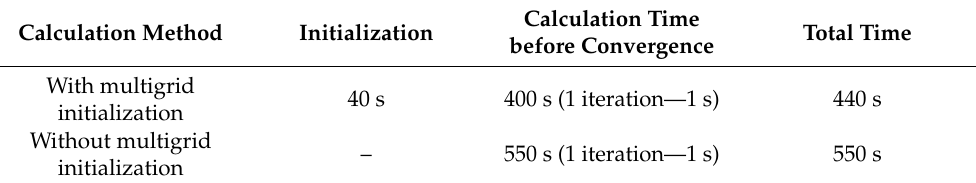
Figure 13. Drag convergence.